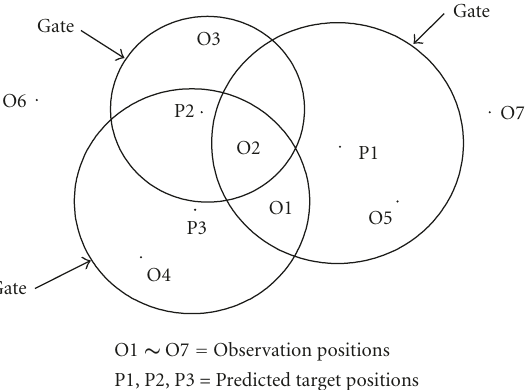
Figure 2: Relationship between predicted objects and measure- ments based on the gating technique.